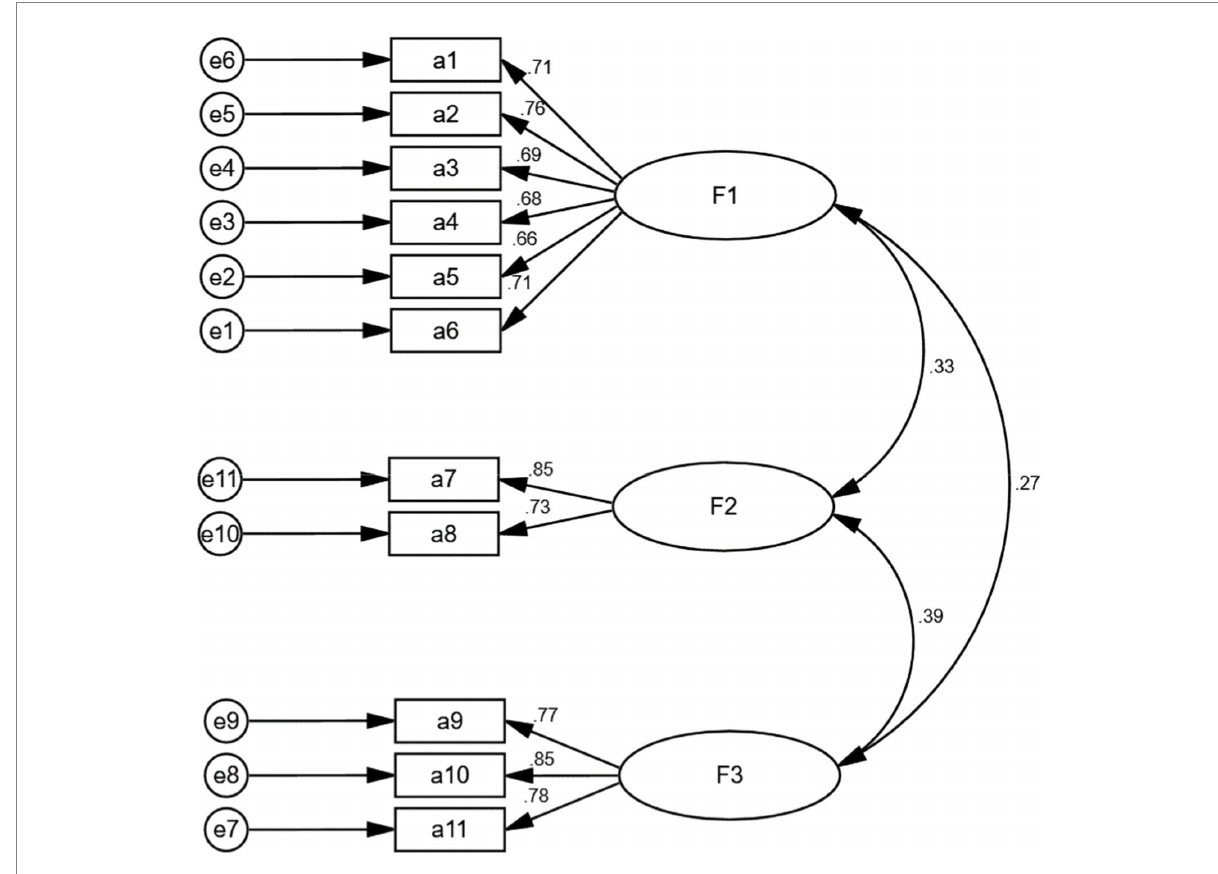
FIGURE 3 Standardized three-factor structural model of the ATREND ( n =